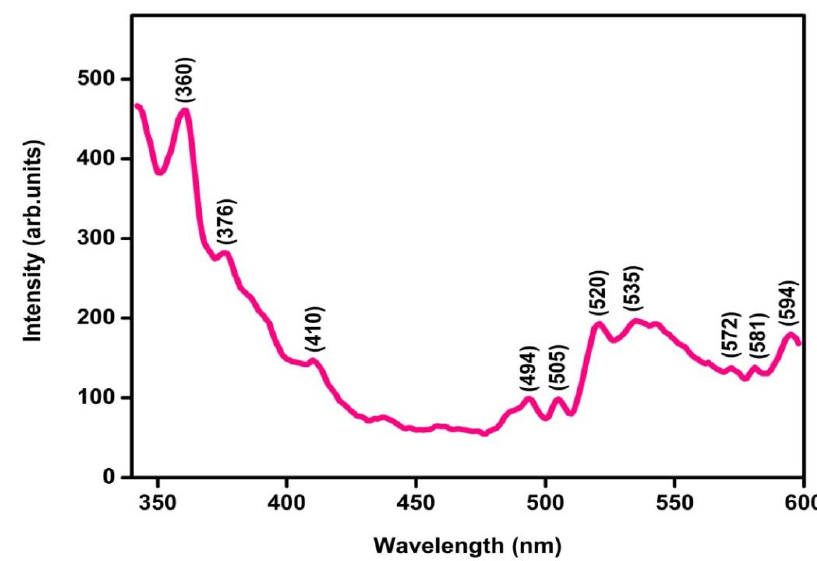
Figure 6. PL emission spectrum of Ni 2+ -doped HApNPs calcined at 500 °C.